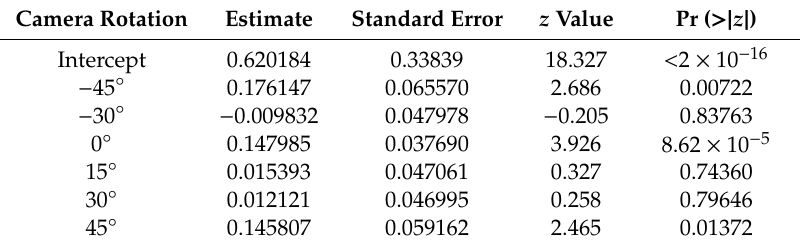
Table 4. Logistic regression analysis results of the camera rotation.